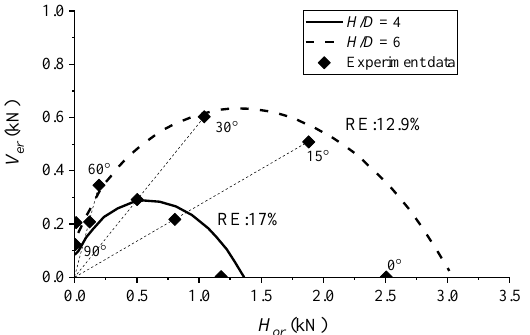
Figure 9. Comparative study based on model tests conducted by Gao et al. [35,45].